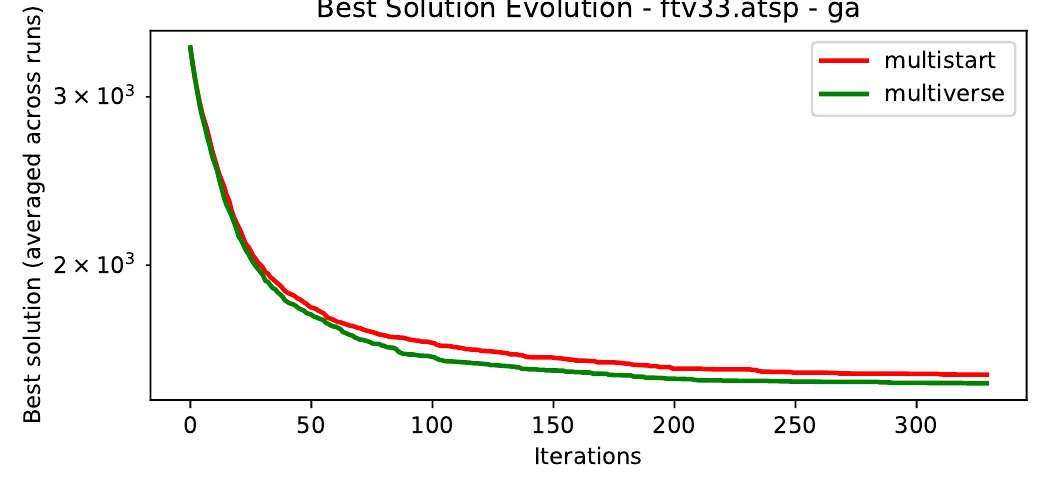
Figure 5. Typical evolution of best Genetic Algorithm solution versus iteration for Multistart and Multiverse. Each line follows the average of the best solutions across the 25 runs at the corresponding iteration for their respective method. The Y axis is shown in logarithmic scale.